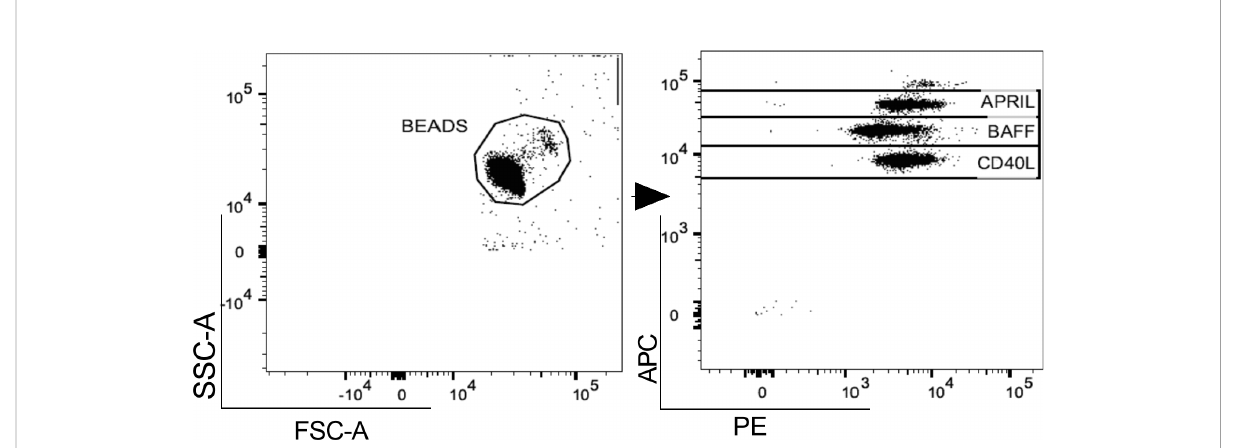
FIGURE 1 Gating strategy. A. Representative fl ow cytometry plot for the evaluation of plasma APRIL, BAFF and CD40L levels after bead-based multiplex assay panel. APRIL, A-proliferation inducing ligand; BAFF, B-cell activating factor; CD40L, CD40